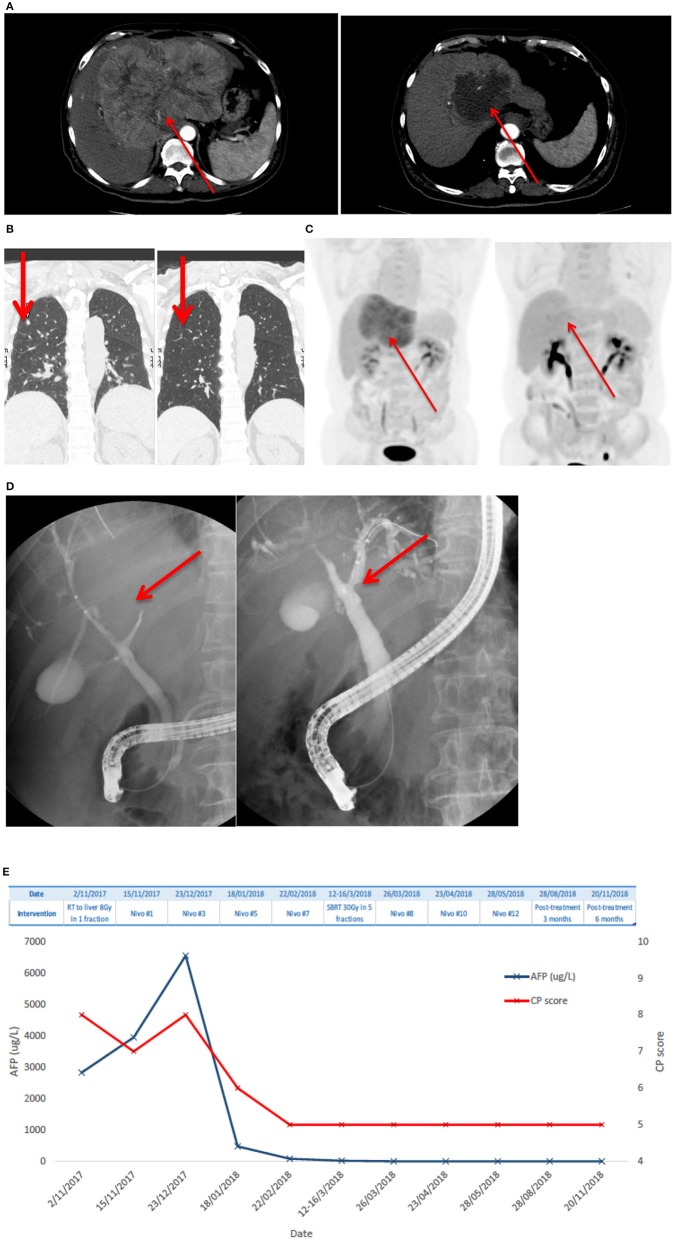
Patient #1 had advanced HCC and lung metastases who achieved complete remission after one single dose of 8 Gy SBRT and anti-PD1 antibody, followed by additional dose of 30 Gy in 5 fractions SBRT. (A) Shows a large arterial enhancing HCC over the left lobe of liver at diagnosis; there is marked reduction of tumor size and enhancing component of the lesion after radiotherapy and Nivolumab. (B) Demonstrates the complete resolution of lung metastases. (C) Shows that PET-CT revealed complete metabolic resolution of HCC. (D) Shows a compressed left main hepatic duct with minimally visible peripheral ducts on endoscopic retrograde cholangio-pancreatography (left) and resolved compression with fully visible ductal-branches after the treatment. (E) Shows AFP level and CP scores at different time points. AFP level improved and CP score improved over time.